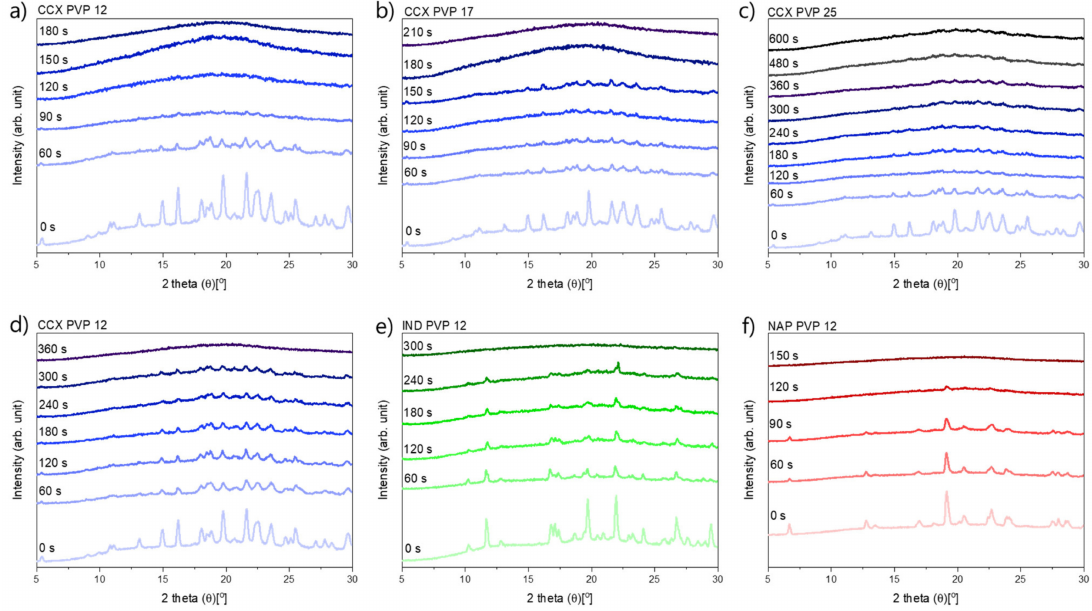
Figure 2. XRP-diffractograms at various exposure times. ( a – c ) exposed at a laser intensity of 1.52 W/cm 2 , ( a ) CCX PVP12, ( b ) CCX PVP17, ( c ) CCX PVP25, ( d – f ) exposed at a lower laser intensity of 1.02 W/cm 2 , ( d ) CCX PVP12, ( e ) IND PVP12, ( f ) NAP